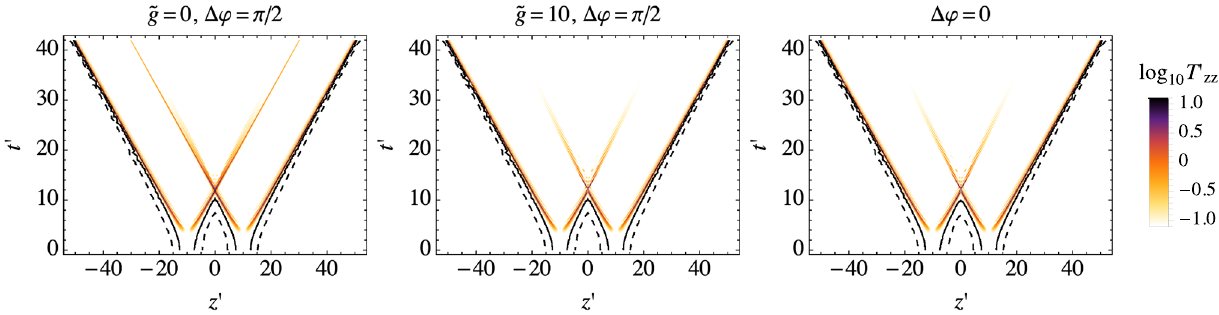
Fig. 4 Collision of two bubbles with initial complex phase difference (cid:10)ϕ = π/ 2. The solid and dashed curves correspond to | φ (cid:14) | = 0 . 1 and | φ (cid:14) | = 0 . 01,respectively.Thecolorcodingindicatesintheleftpanelthe